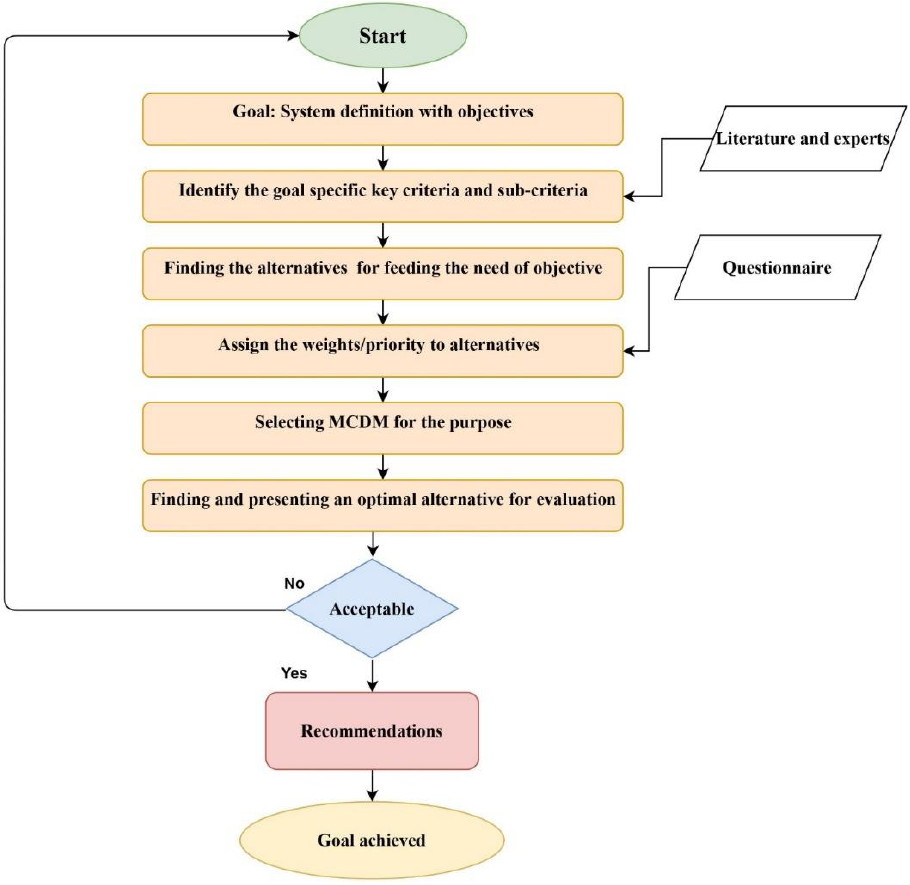
Figure 2. A general procedure of multi-criteria decision methods.